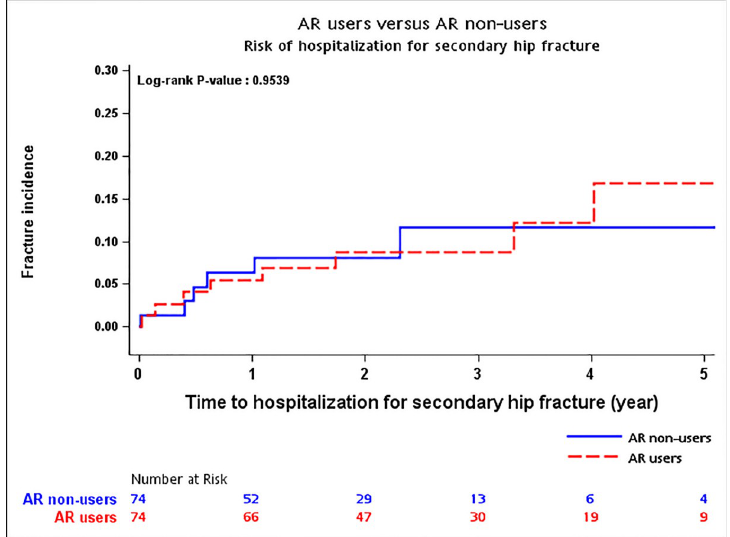
Fig 2. Cumulative incidence of second hip fracture between AR non-users and AR